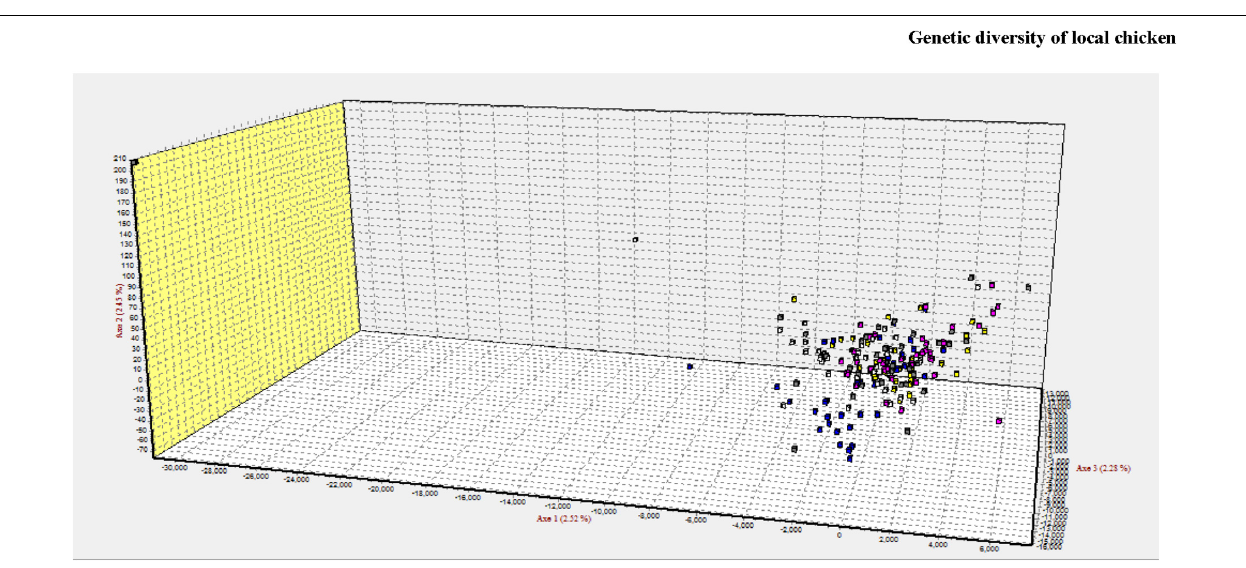
FIGURE 9 | 3D clustering patterns of all individuals analyzed using 20 microsatellite markers as revealed by factorial correspondence analysis (FCA) implemented in